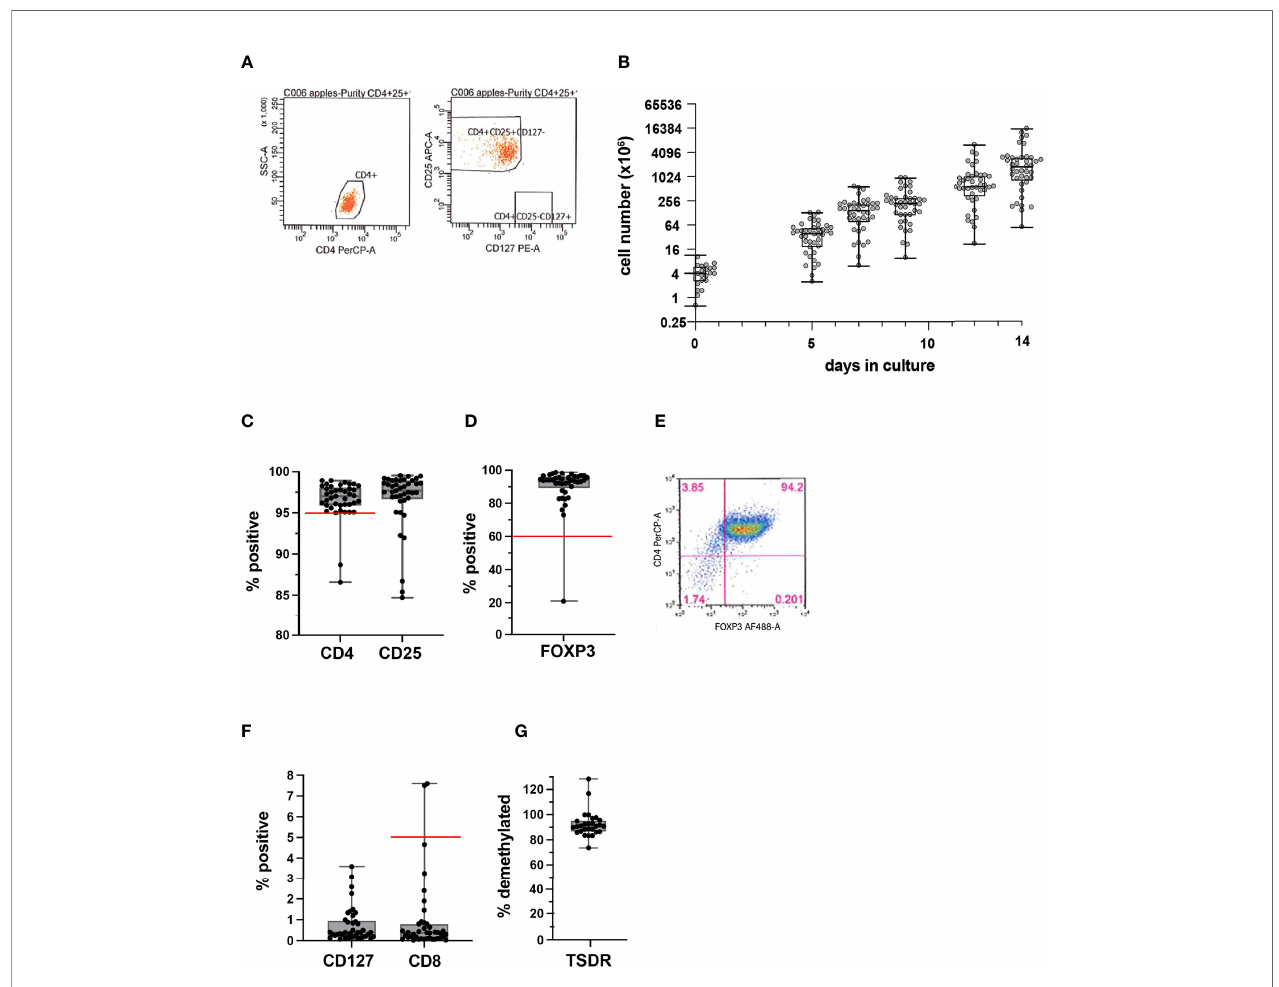
FIGURE 3 | Quality assessment of isolated Tregs and PolyTreg products. Representative fl ow cytometric plots of post-sort purity check (A) . Cell numbers over the 14-day manufacturing period for all products (n=41) (B) . Post-expansion % CD4+, CD25+ (C) , and FOXP3 + in PolyTreg products analyzed by fl ow cytometry (D, E) . CD127, or CD8 expression in Treg products by fl ow cytometry (F) . TSDR methylation of PolyTreg products, expressed as % methylated sites (G) . Release criteria cutoffs are highlighted as a red line in each plot, as